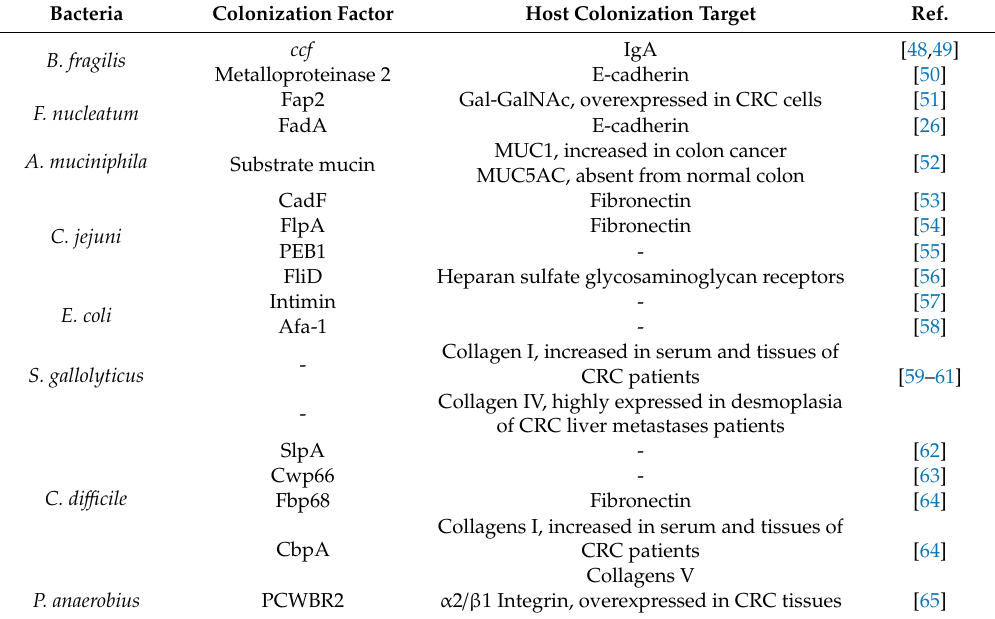
Table 4. Mechanisms for bacterial colonization in the